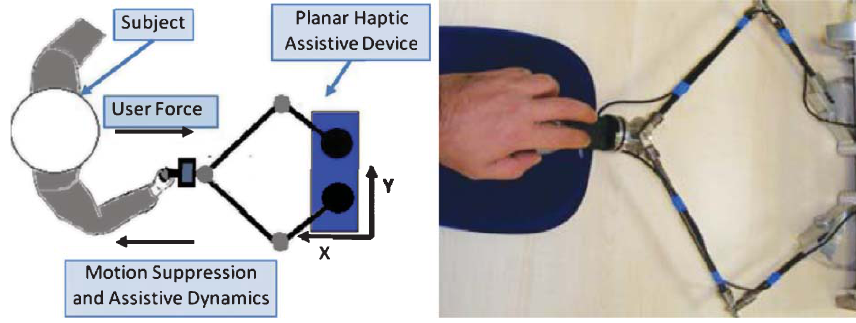
Fig. 3. Schematic diagram of the subject and the planar haptic